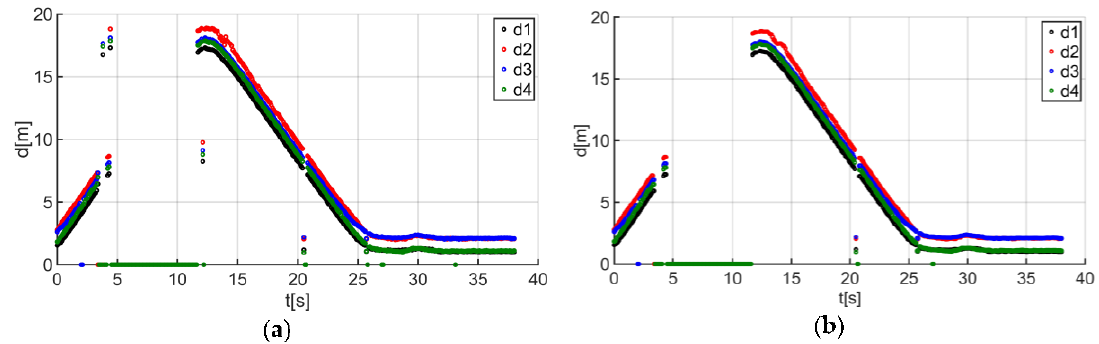
Figure 11. Comparison of the distance measurement results from anchors d i (t), (i = 1, 2, 3, 4): ( a ) before filtering and ( b ) after filtering for trajectory no. 3.